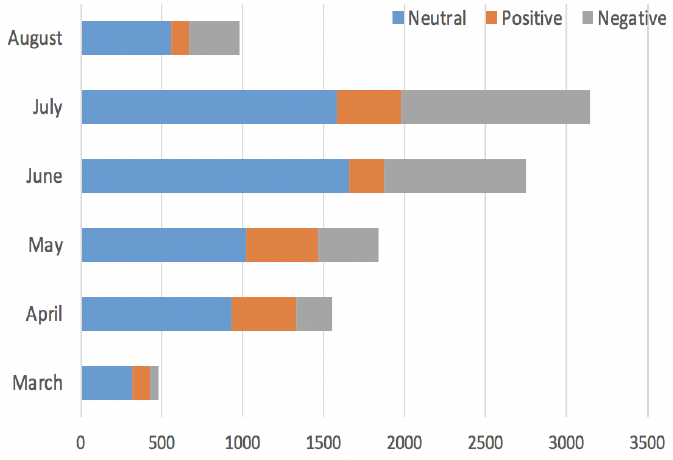
Figure 5. Number of comments across